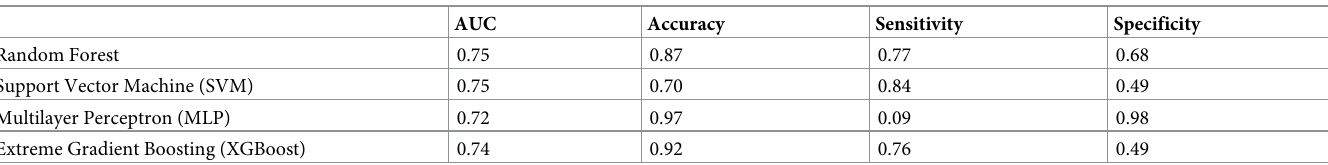
Table 2. Performance metrics of all models on the testing